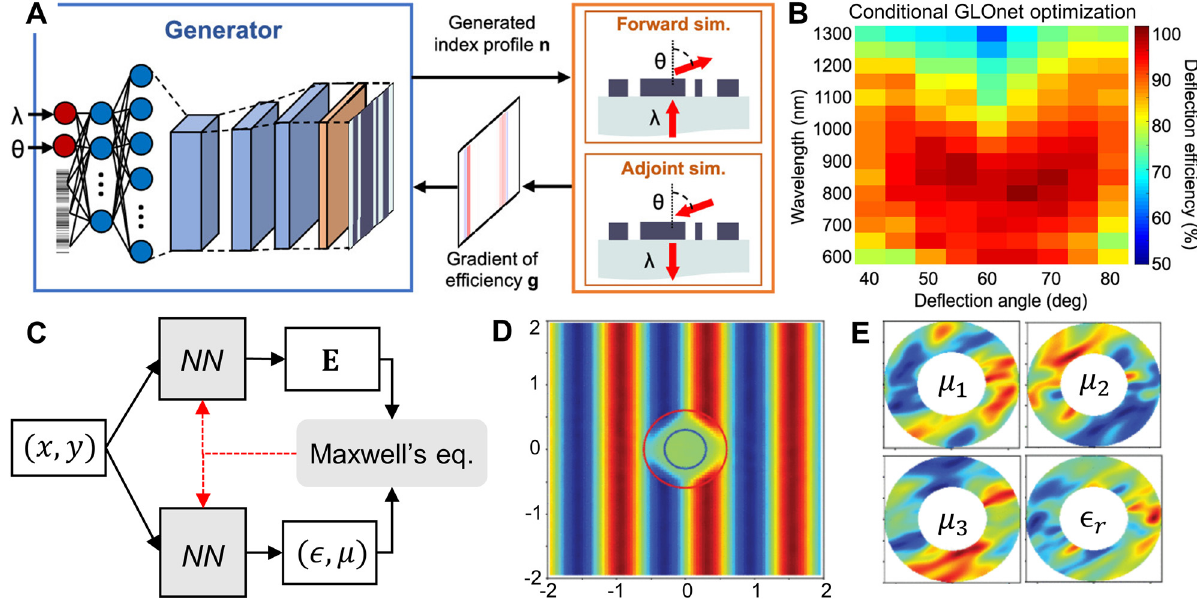
Figure 14: Use of physics-assisted neural network models in free-form nanophotonic device designs. ( A ) A generative neural network for designing a one-dimensional beam de fl ector with high ef fi ciency. The generation network uses gradients fromadjointsimulationfornetworktraining.( B )Theoptimizedresultsfromthegenerativeneuralnetworkin( A ). A,B adaptedwithpermission from [128]. Copyright 2019, American Chemical Society. ( C ) A schematic depicting the neural network for the design of metamaterial (invisibilitycloak).Topneuralnetworkmapsthepositioncoordinatestothe fi eldat